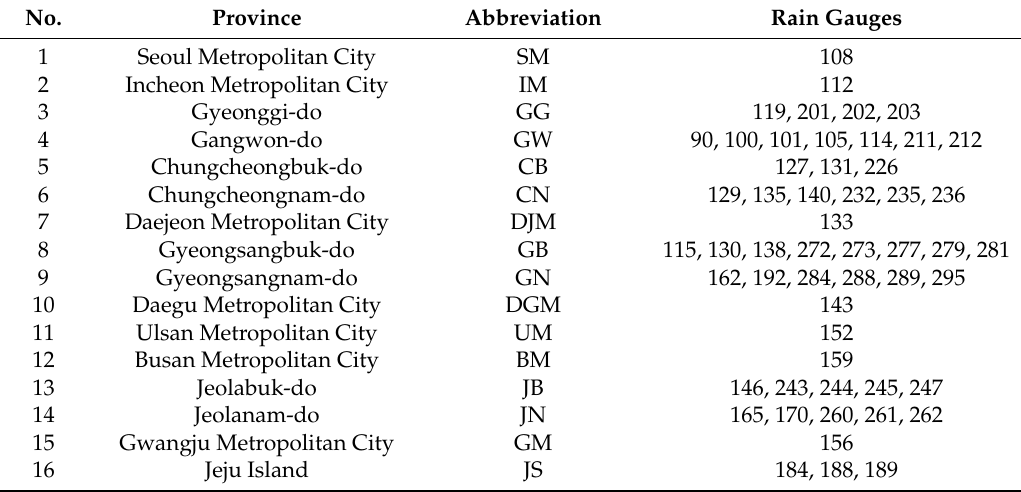
Figure 1. Sixteen ( a ) Provinces in South Korea and ( b ) 60 rainfall gauges used in this study. Table 2. Provinces in South Korea and rain gauges.